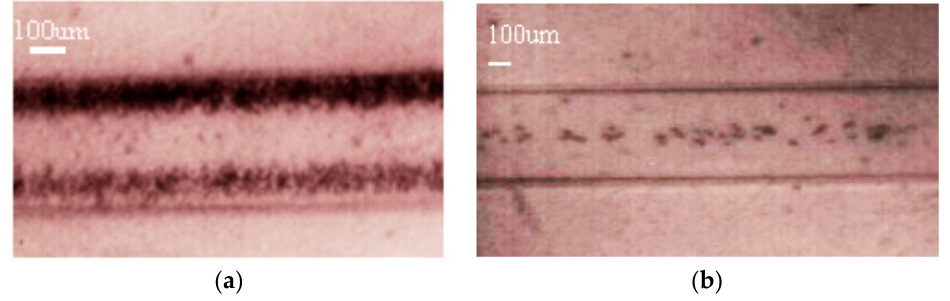
Figure 5. Filmed images of 6 μ m- and 20 μ m-sized polystyrene beads flowing in the channel at a flow rate Q = 100 μ L/min: ( a ) without ultrasounds; and ( b ) exposed to the ultrasounds at f = 0.952 MHz. The bigger circulating particles (20 μ m) collected along the central axis within the buffer while smaller particles kept flowing beside the sidewalls (images have poor quality due to the translucent polymer covering the top of the channel and the high speed of the particle flow).